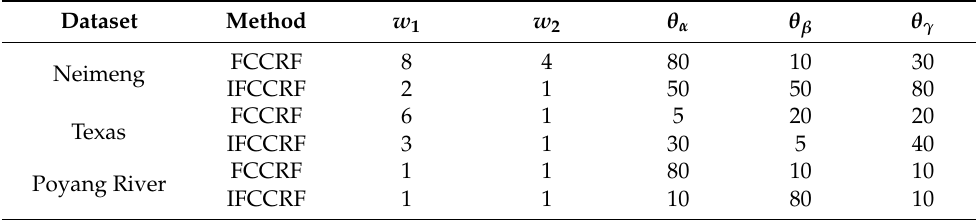
Table 2. The values of the parameters of FCCRF and IFCCRF used in the experiments.